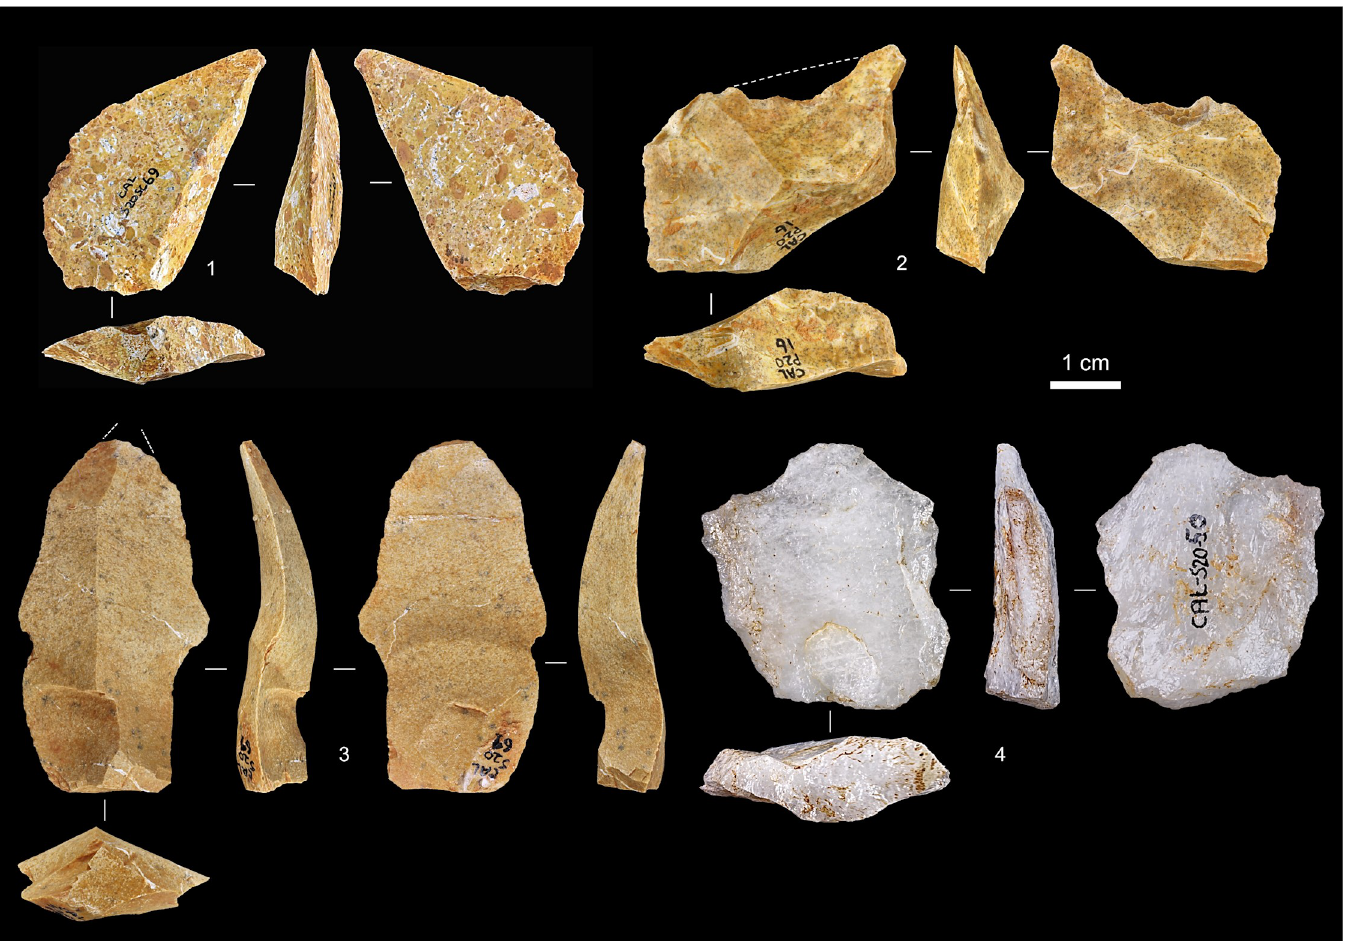
Fig 19. Entrance trench: Middle Palaeolithic debitage. 1. Kombewa flake, silcrete (S20sc69). 2. Pseudo-Levallois point, silcrete (P20-16; excavation-damaged; the dashed line indicates the outline of the item’s original edge). 3. Laminar flake, silcrete (S20-61). 4. Levallois flake, quartz (S20-50). Nos. 1–2 are from Unit 5, nos. 3–4 from Unit 6.